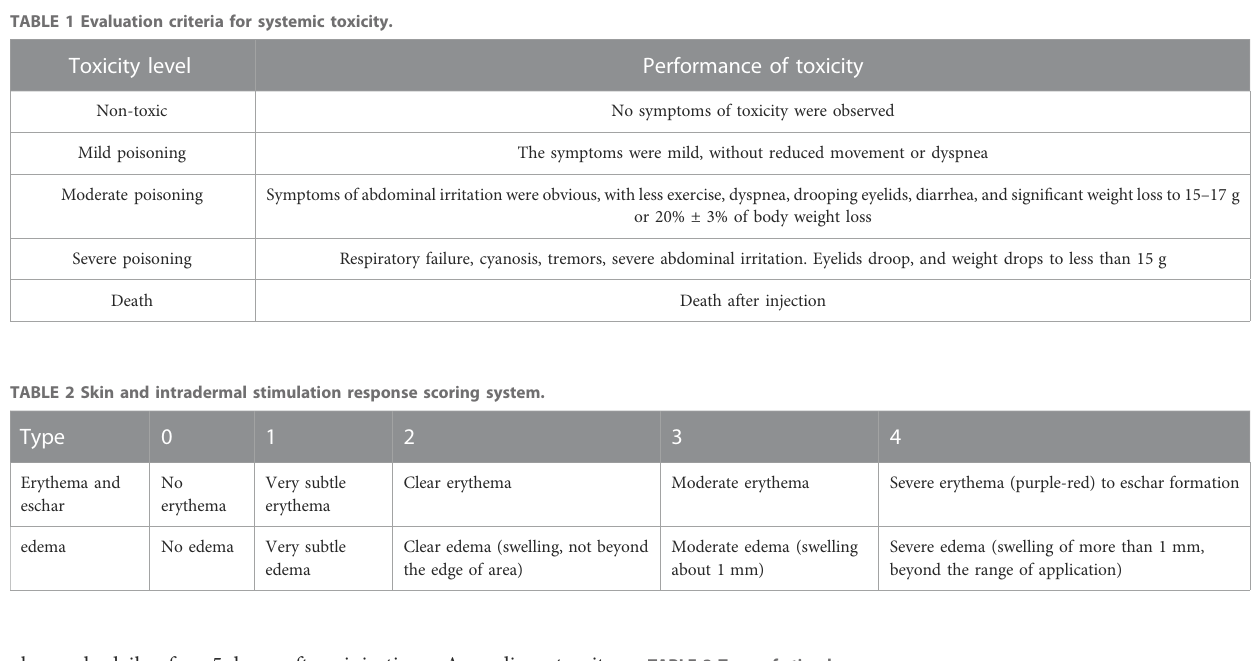
TABLE 3 Type of